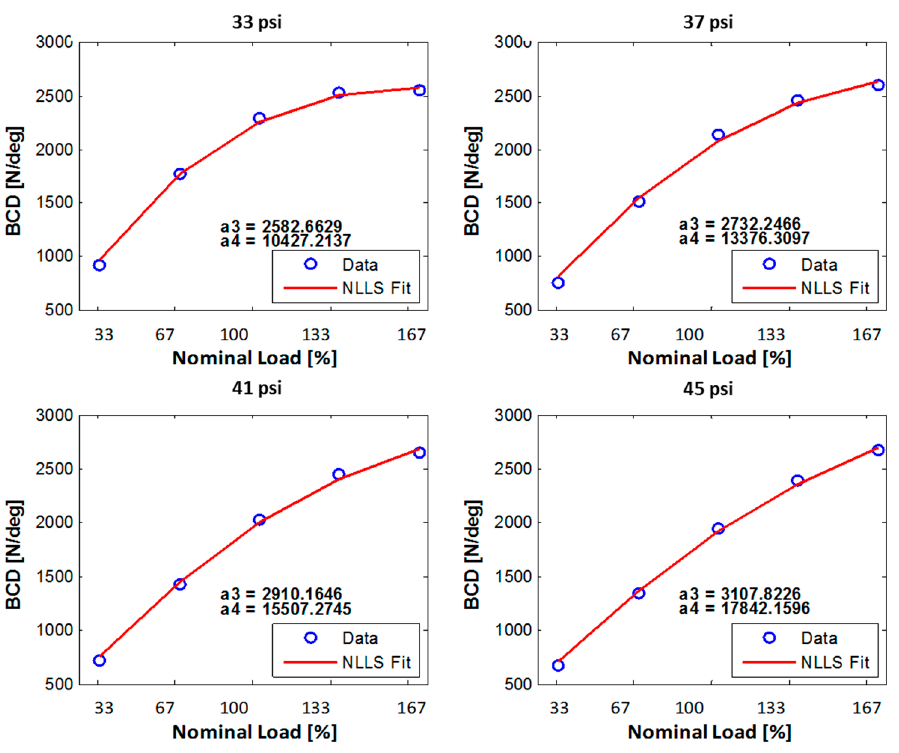
Figure 16. Nonlinear least-squares (NLLS) fitting results—‘a3’ and ‘a4’ coefficient. BCD = tire cornering stiffness.